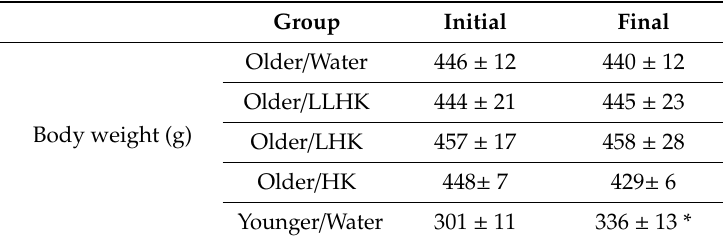
Table 1. Body weights in water-treated and peptide-treated groups.